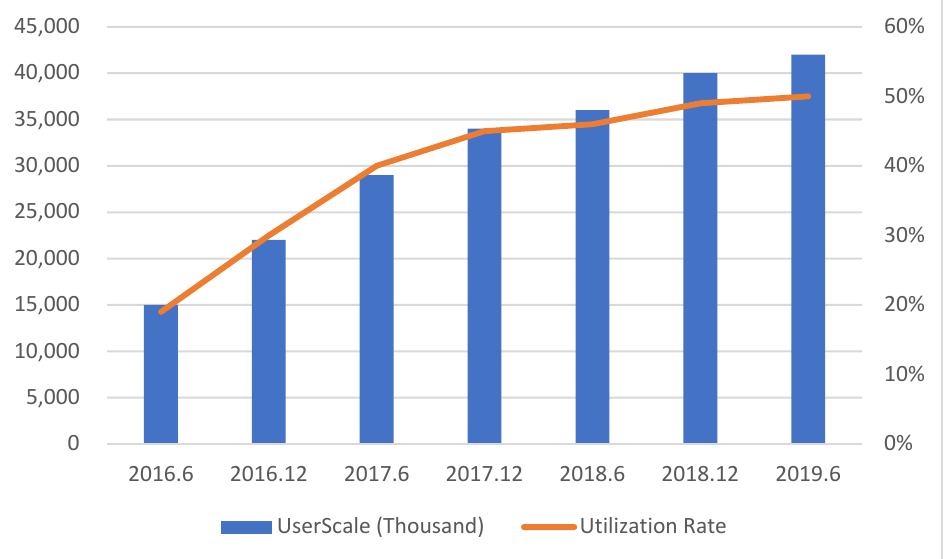
Figure 2. Changes in the scale of China’s food delivery industry from 2015 to 2019 (100 million Yuan).